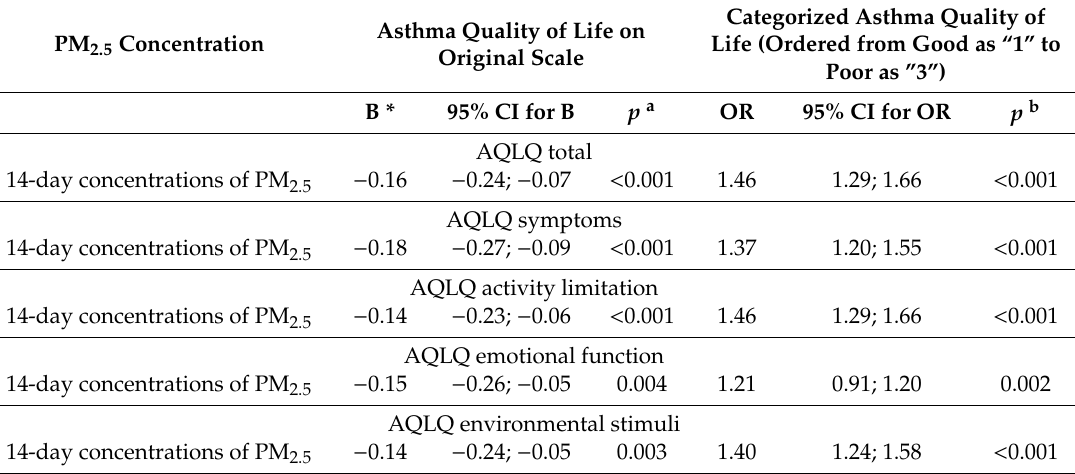
Table 3. Impact of mean 14-day concentration of PM 2.5 (increasing unit: 10 µg/m 3 ) on asthma quality of life and the risk of poor asthma quality of life, adjusted to potential confounders.